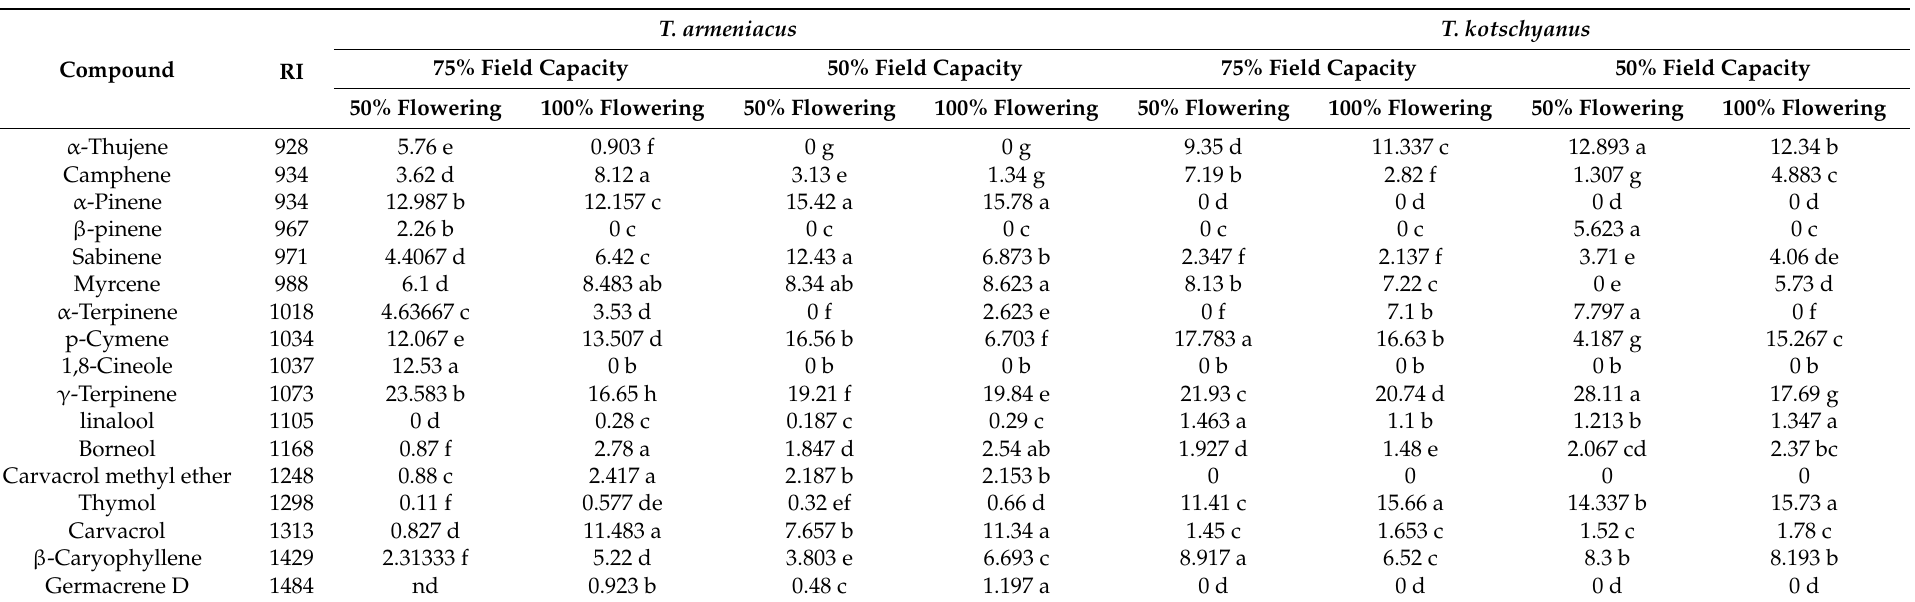
Table 5. Effect of irrigation regime on essential oil composition of two Thymus species at two developmental stages (50 and 100% blooming). Within each column, different letters indicate significant differences ( n = 3). Retention indices (RI) were generated with a standard solution of n-alkanes (C 6 –C 24 ) on the HP-5MS column. nd—no difference. The full range of documented compounds is provided in Supplementary Table